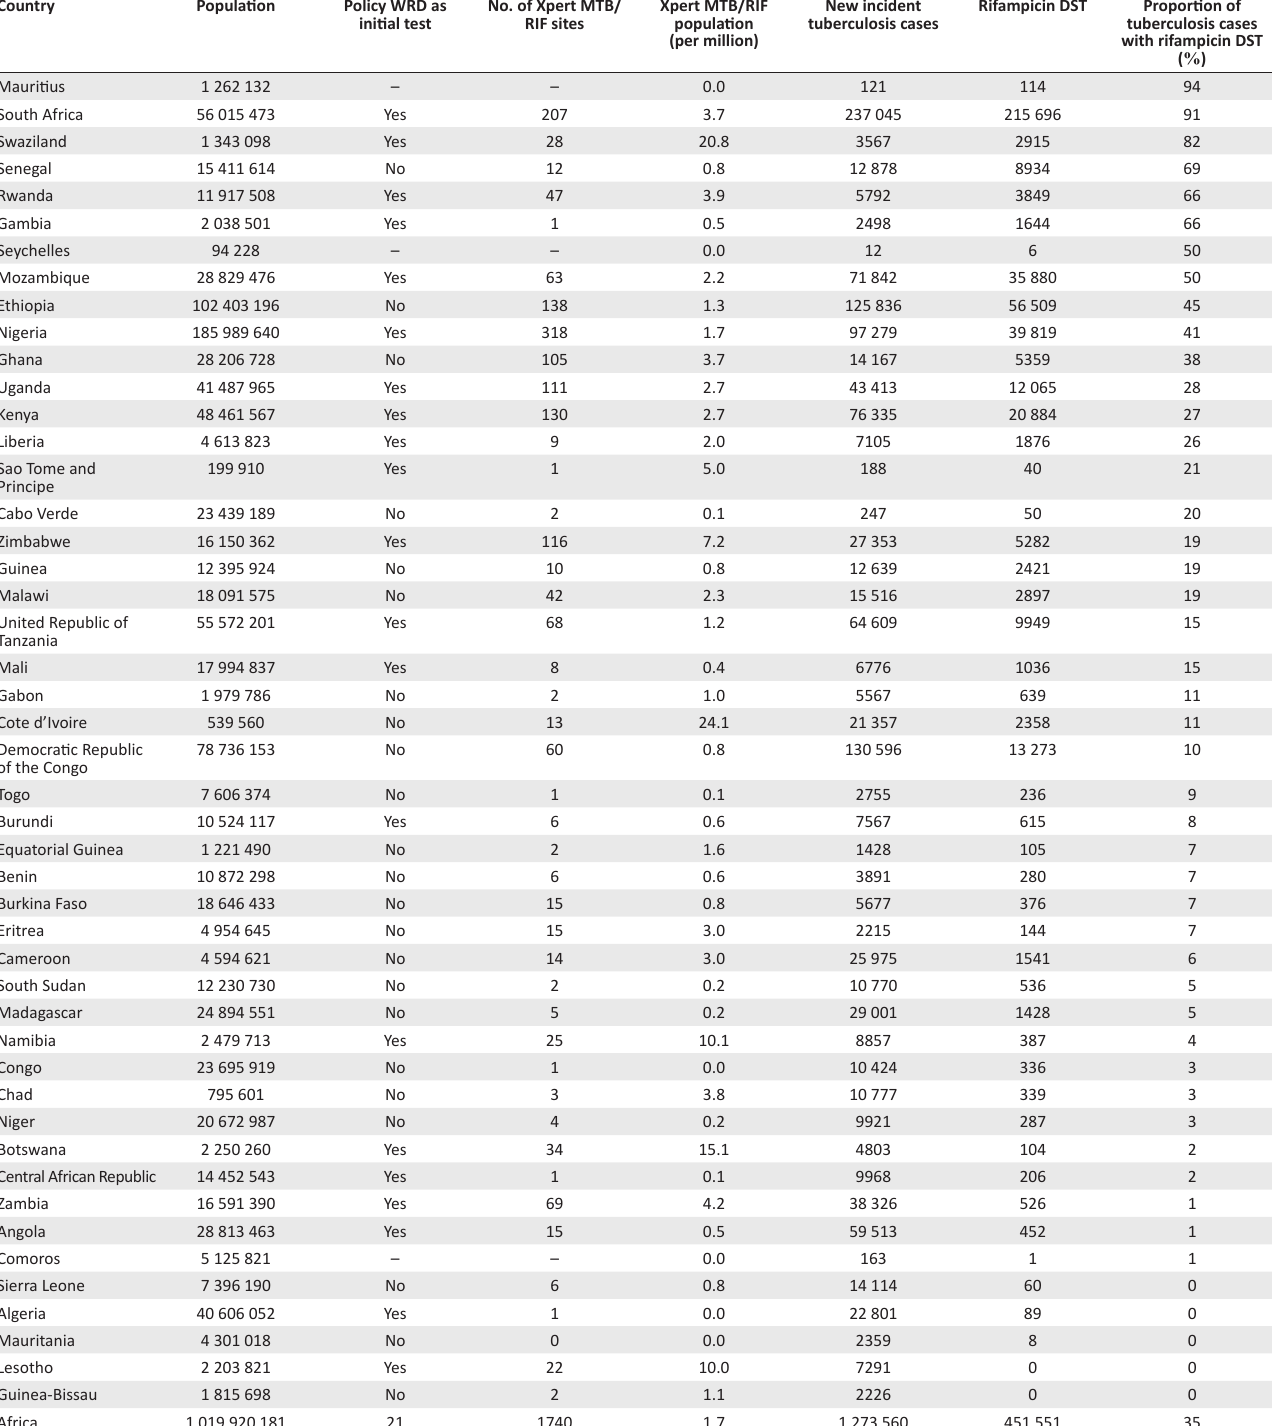
TABLE 1: Rifampicin resistance detection in Africa from policy to application.